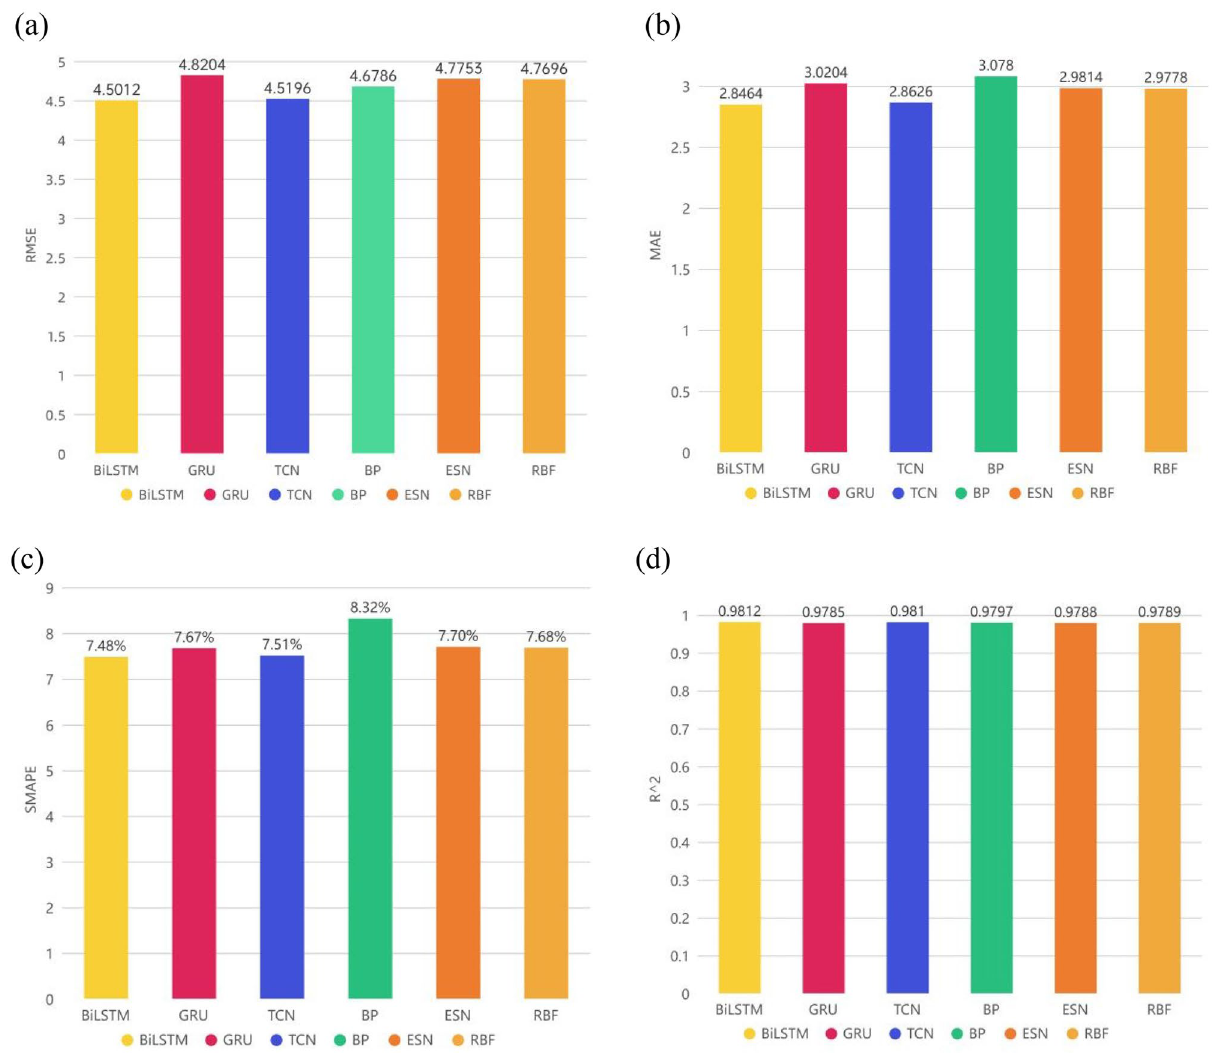
Figure 6. Column chart of single model prediction evaluation index comparison: ( a ) RMSE; ( b ) MAE; ( c ) SMAPE; ( d ) adjusted R 2